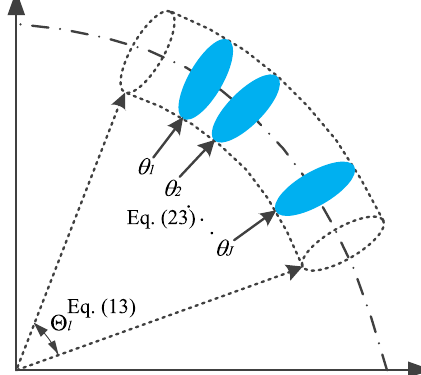
Fig. 2 Concept of INCM reconstruction method based on GLQ and uncertainty